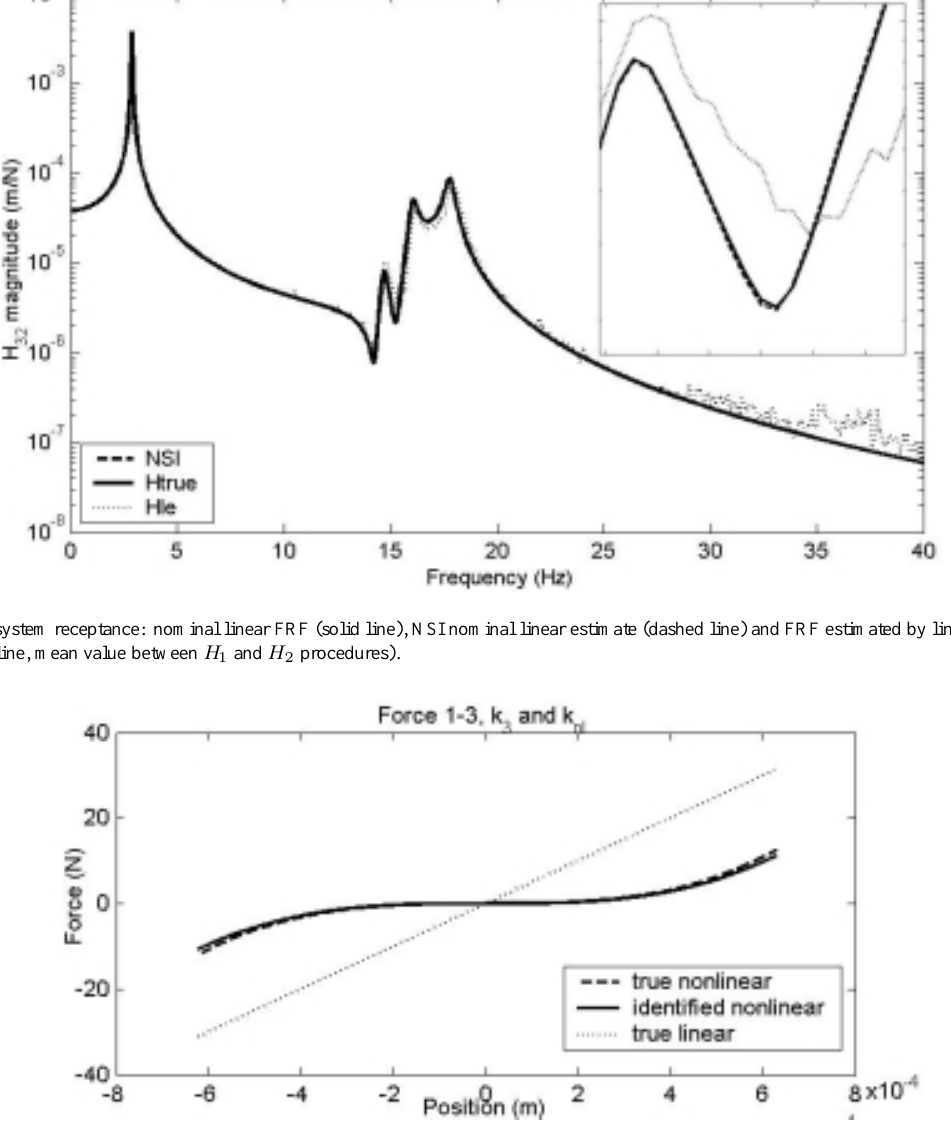
Fig. 4. Stiffness characteristics between mass 1 and 3: true nonlinear (dashed line), NSI estimate (solid line) and true linear (dotted line). shown in Fig. 6 consists of helical wire rope isolators mounted between the load mass and the base mass of an electrodynamic shaker. The acceleration a 2 of the load mass, the acceleration a 1 of the bottom plate, the force F and the relative displacement u 12 between top and bottom plate are measured. Excitation is white noise low pass filtered at 400 Hz, producing records of approximately 5 × 10 5 samples for each channel, sampled at 4096 Hz, with different levels of excitation and two different load